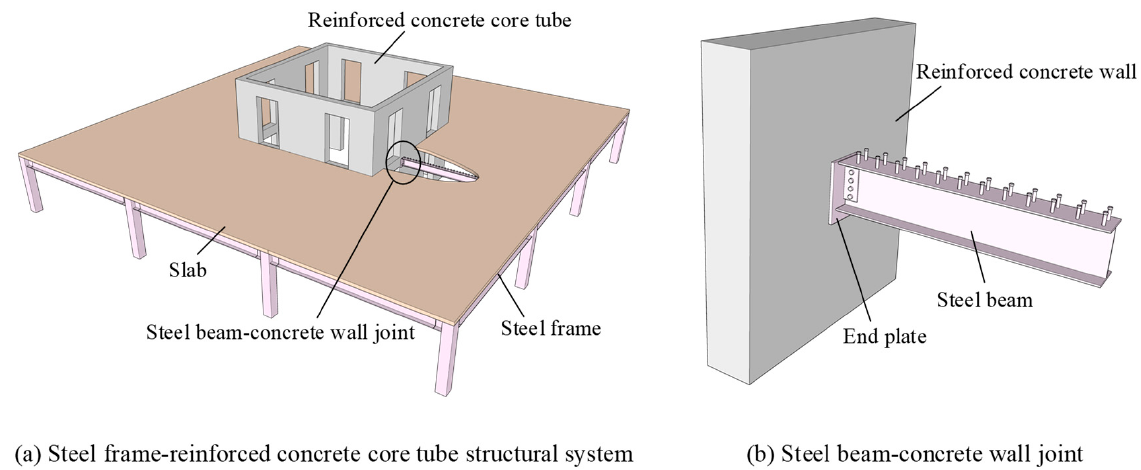
Figure 1. The SBCW joint in a steel frame ‐ reinforced concrete core tube structural system.